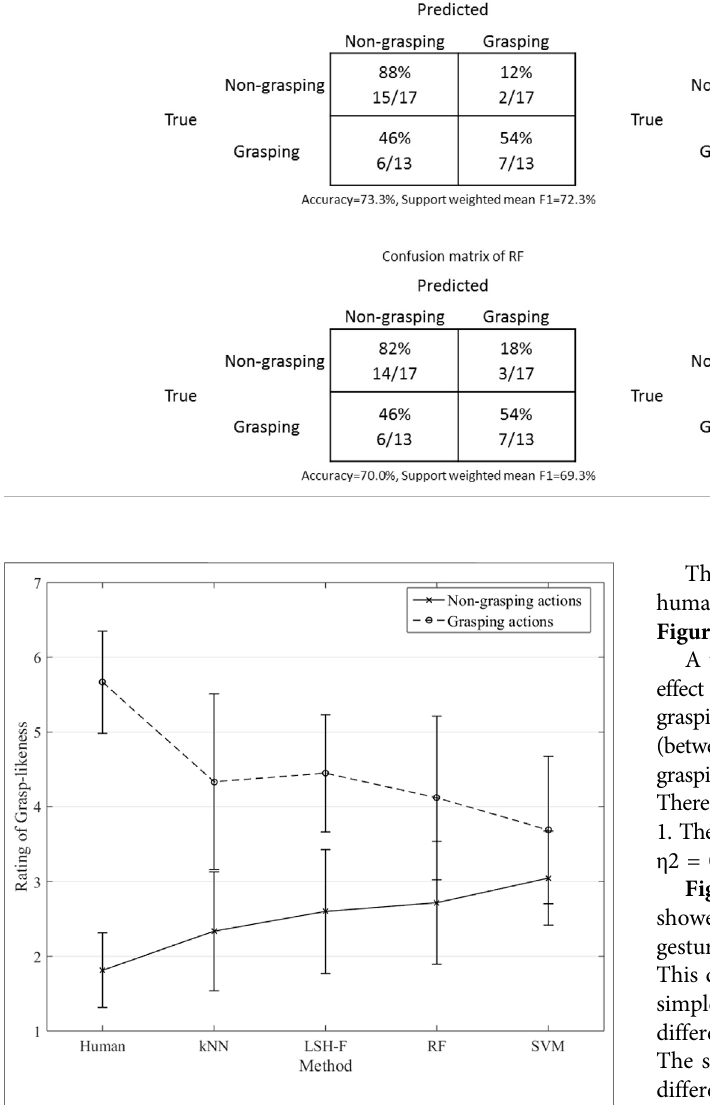
Frontiers in Robotics and AI |